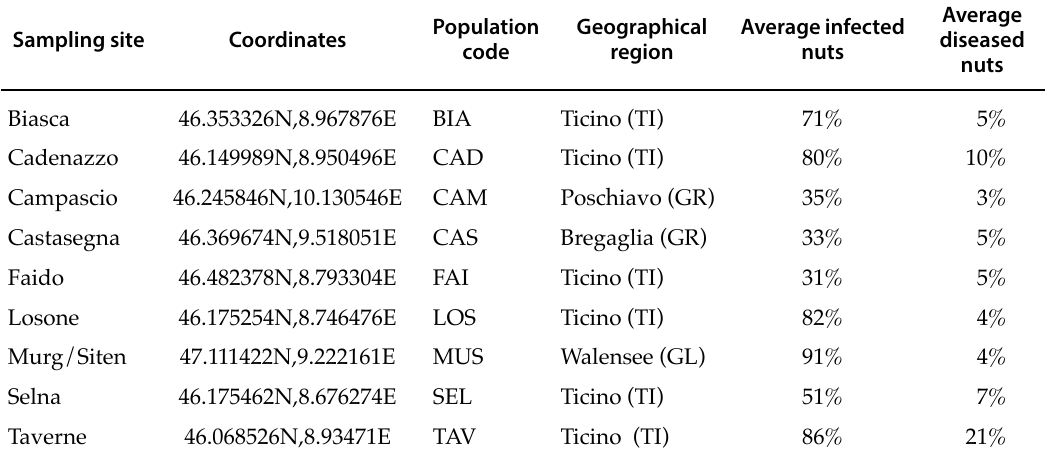
Table 1. Geographical WGS84 datum coordinates of sampling sites and geographical regions where sweet chestnuts were sampled. Canton of the sampling locations are given in parenthese. Average number of infected nuts (nuts from which Gnomoiopsis castanea were be isolated) and diseased nuts (nuts with G. castanea symptoms) are given for each location.